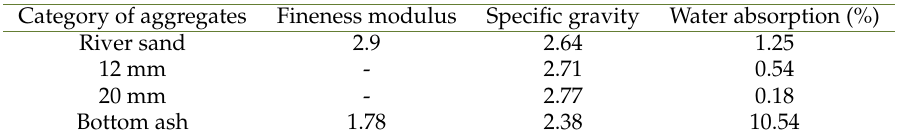
Table 2. Physical properties of FAs.